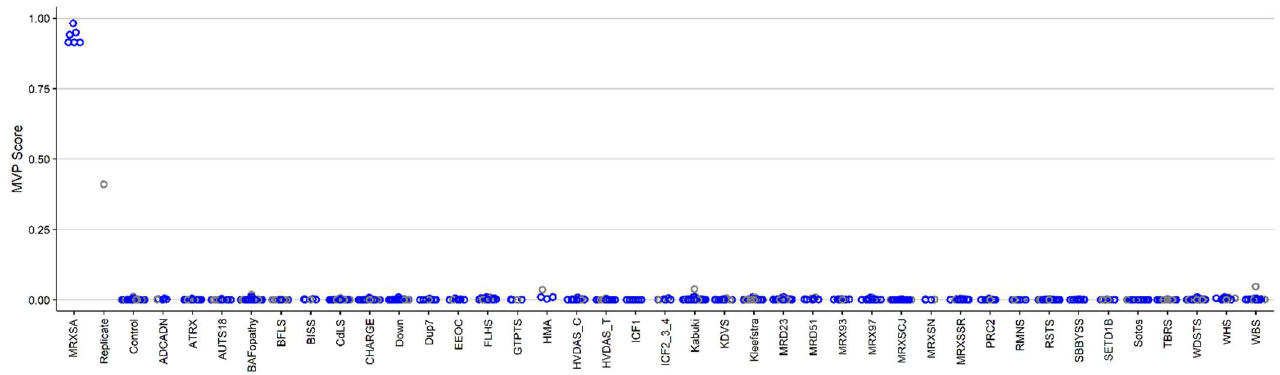
Figure 5. The MVP scores created by the SVM trained by comparing cases of MRXSA against healthy control subjects and samples from 38 other constitutional EpiSign disorders. The blue circles represent the training samples and the grey circles the testing samples. Table 2. List of syndromes with a defined episignature, used for training a more accurate SVM.